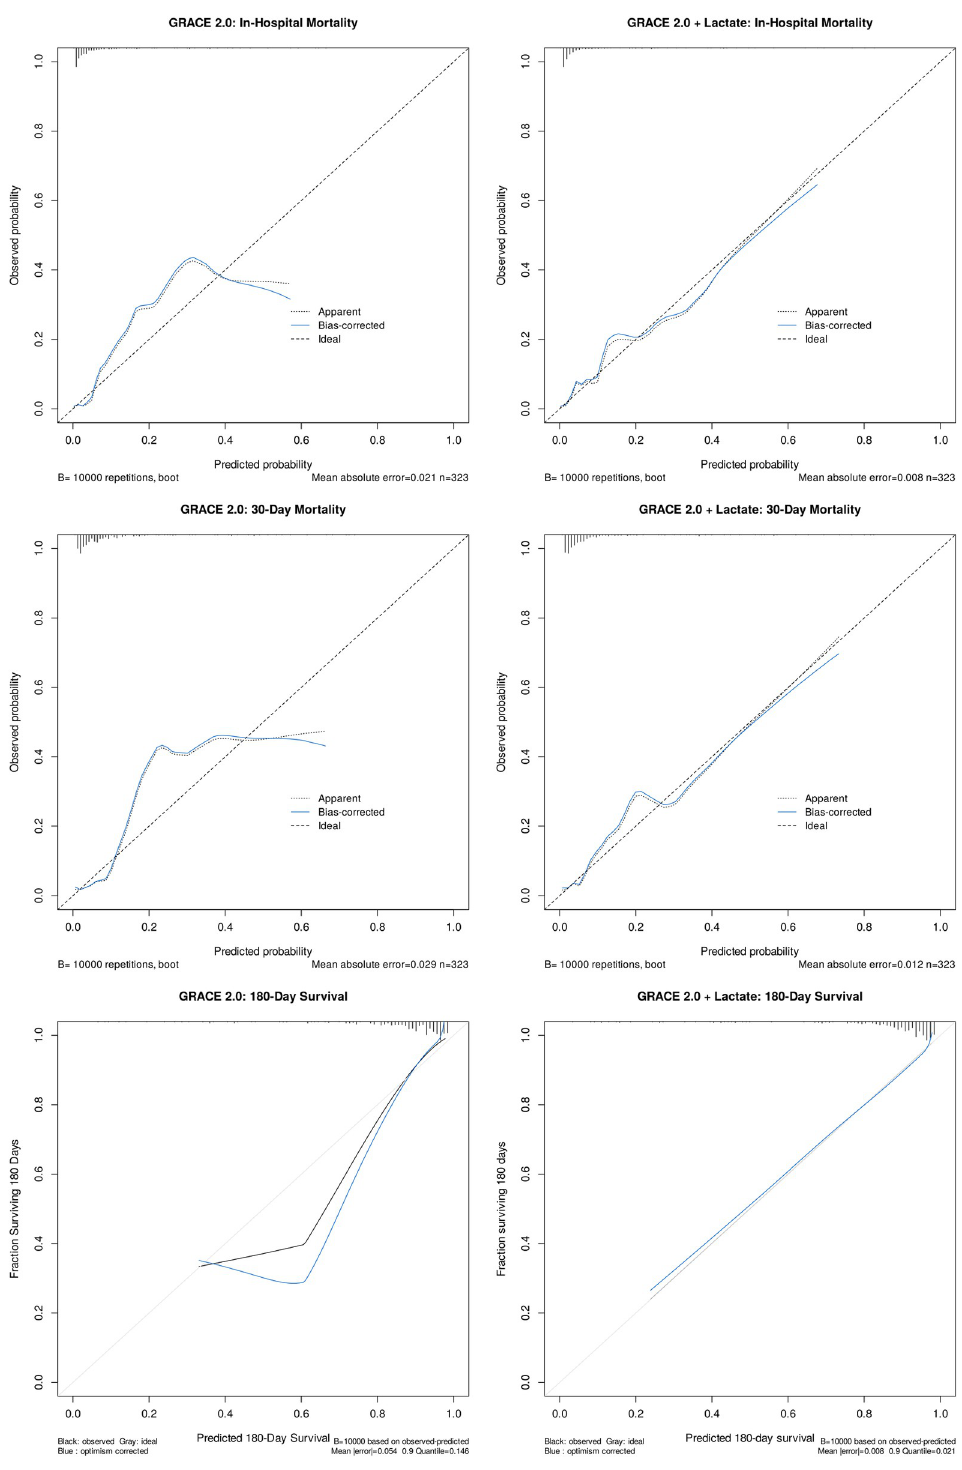
Fig 4. Calibration plot of the apparent and optimism-corrected models. Calibration curves were created using a smoother on the scatter plot of expected versus observed risks. Differences between predicted and observed event rates were smaller in the expanded models in both apparent and optimism-corrected models, as shown by the decreased mean absolute error. The rug plots across the top of the figures show distribution of predicted risk. Also, the le Cessie- van Houwelingen-Copas-Hosmer test for global goodness of fit demonstrated better model fit in all apparent expanded logistic regression models (Table 3).